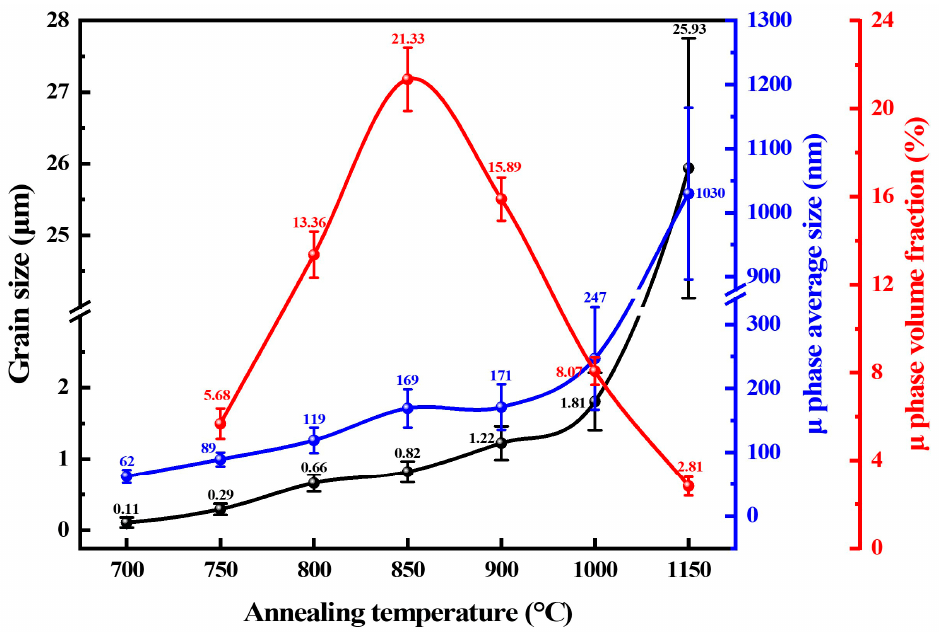
Figure 4. The variation in the average size and fraction of the μ -phase with the annealing tempera- ture and the recrystallized grain size at the corresponding